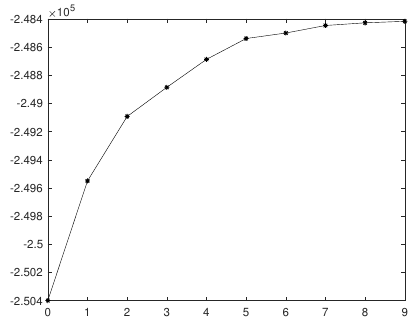
Figure 5. Improvement of AIC at each iteration for summertime